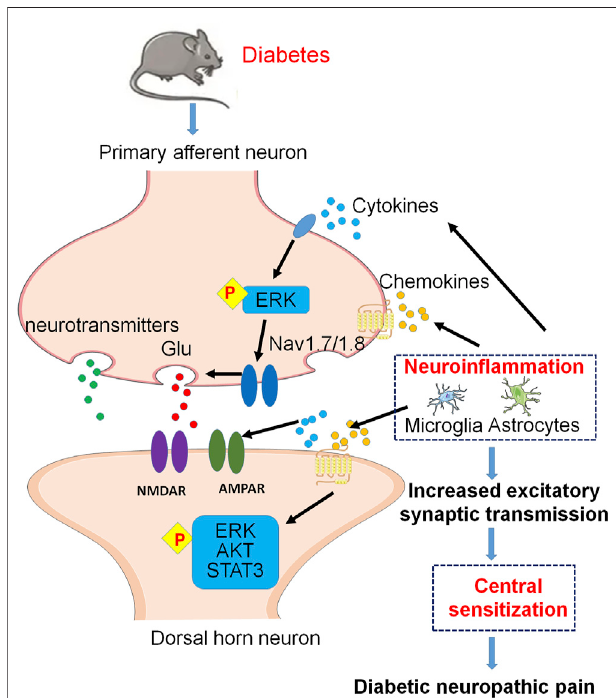
FIGURE 2 | Molecular mechanisms of neuroin fl ammation and central sensitization in excitatory synapses of the spinal dorsal horn under DNP. Cytokines and chemokines from spinal glial cells activate pERK in primary afferent terminals and fi nally enhance glutamate (Glu) release via activation of Nav1.7 and Nav1.8. At postsynaptic membrane, activation of postsynaptic Glu receptors contributes to central sensitization. In addition, cytokines and chemokines activate postsynaptic pERK, pAKT, and pSTAT3 signaling pathways, which contribute to central sensitization of